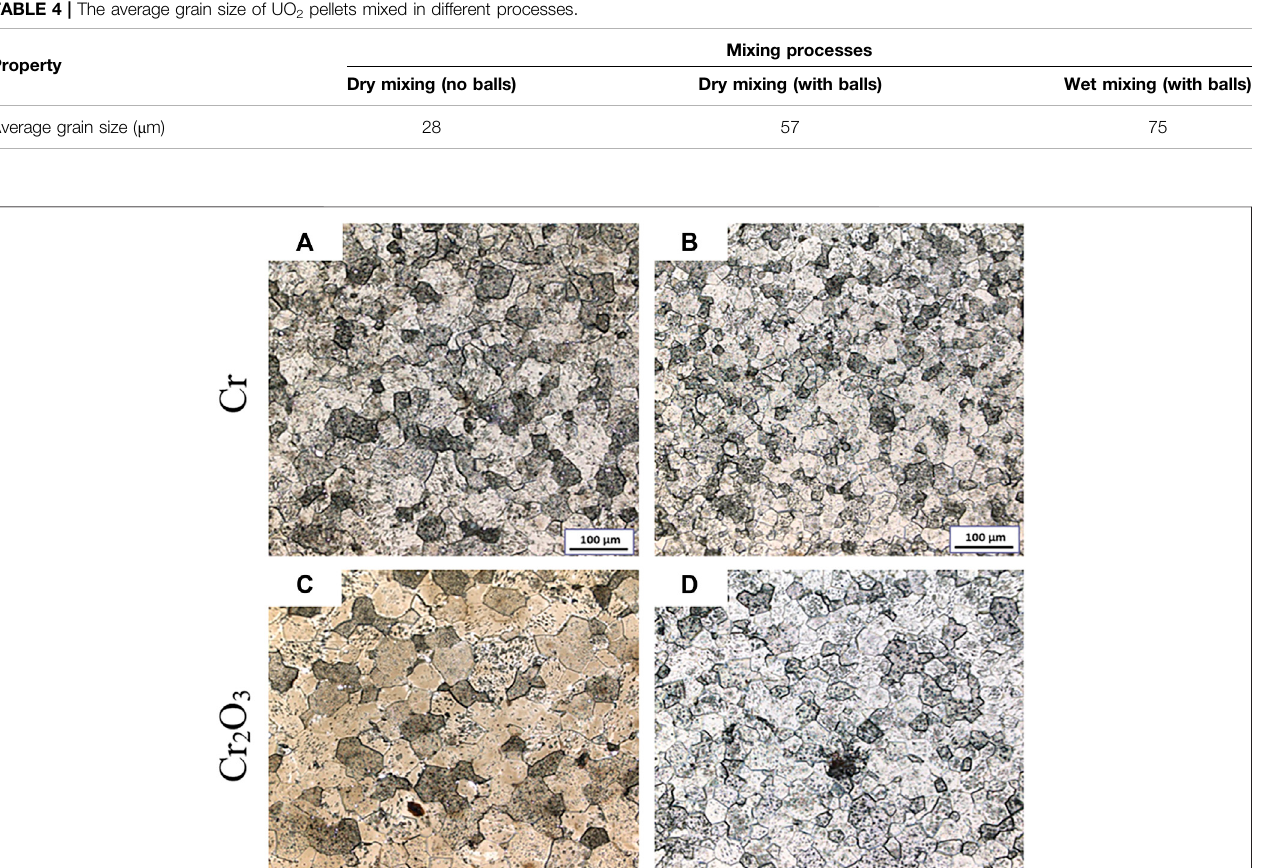
Frontiers in Materials |